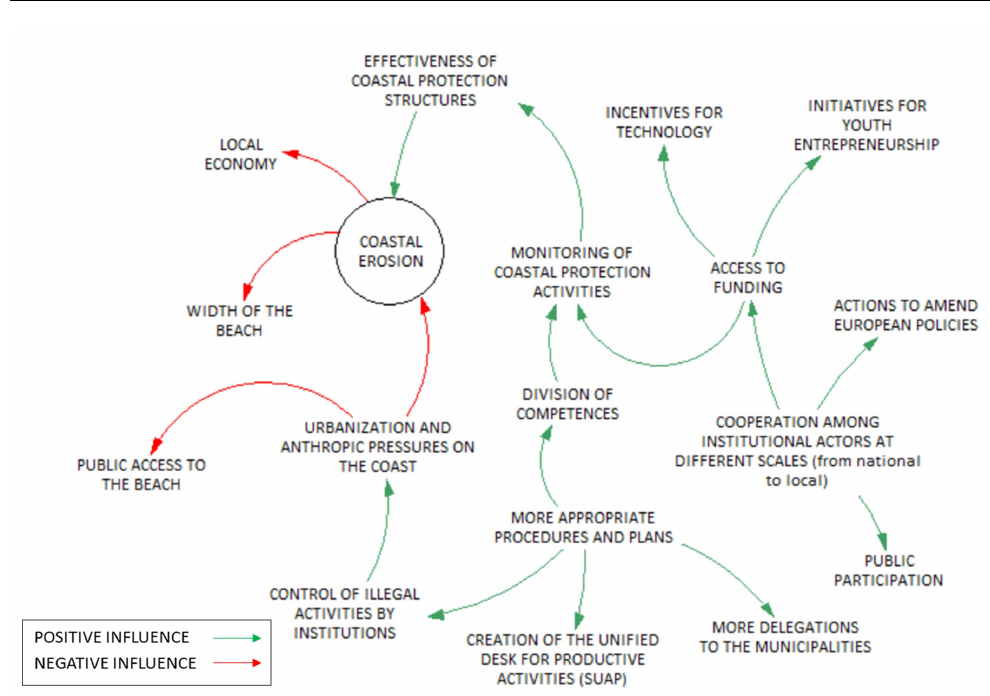
Figure 5. C-FCM of Step 3—the coastal risk perception in the test site as result of the Scenario Workshop. Coastal erosion was identified as caused by the excessive urbanization and anthropic pressures on the coast. On the other hand, it exerted direct negative impacts on the local economy and the width of the